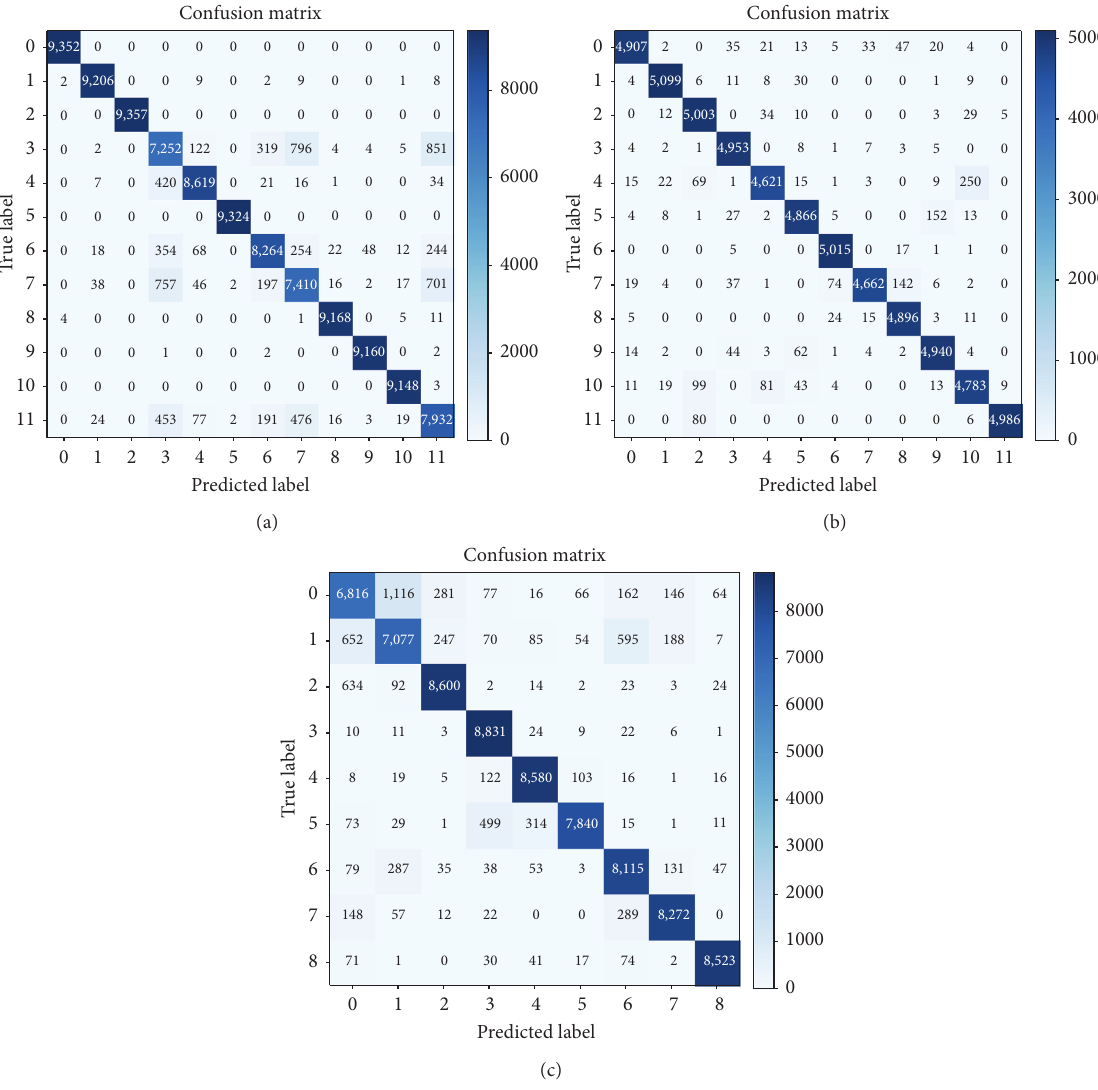
Figure 8: Confusion matrix by deep neural network in making predictions of weapon type, region, and attack type. (a) Confusion matrix of weapontype indeepneuralnetwork.(b)Confusionmatrix ofregionin neuralnetwork.(c) Confusionmatrix ofattacktypeindeep